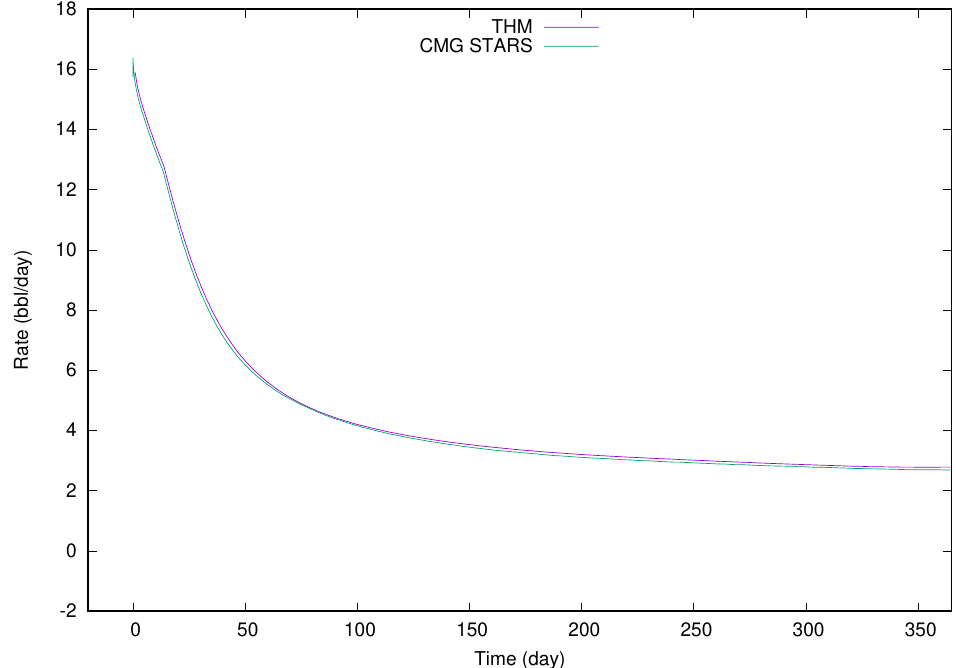
Figure 12. Example 2: oil production rate (bbl/day), first production